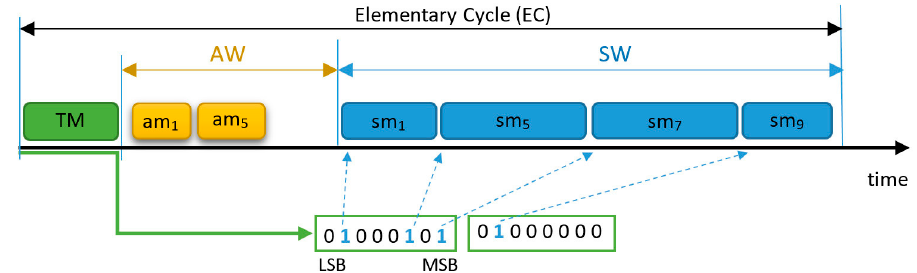
Figure 1. Elementary Cycle (EC) and Trigger Message (TM) encoding in Flexible Time-Triggered-Controller Area Network (FTT-CAN).